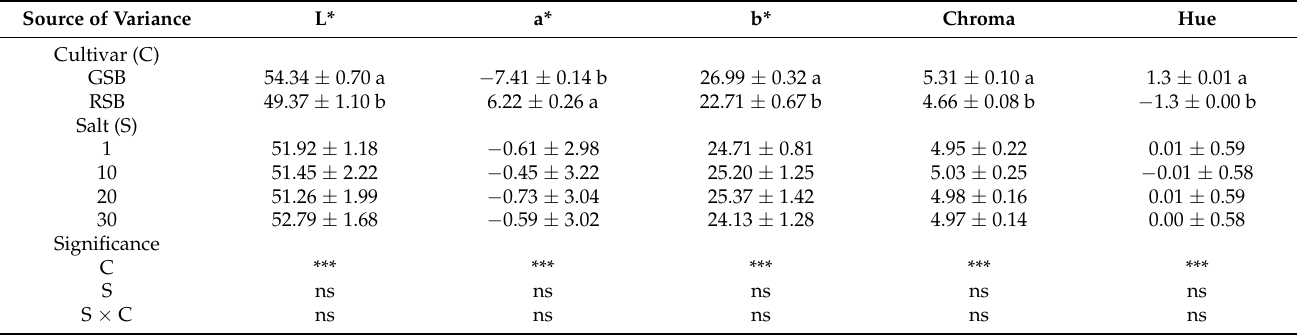
Table 2. Main effect of the cultivar (C), salt concentration (S; in mM NaCl), and their interaction on the colour parameters of the leaves. The significance of the factors and their interactions was evaluated with a two-way ANOVA (ns: not significant; *: p < 0.05; ***: p < 0.001), using Duncan’s multiple range test as post-hoc test for mean separation among conditions. In case of simple main effect of C or S, different letters indicate, for each variable, different homogenous groups according to Duncan’s test for S, or the Student’s t -test for C. GSB: ‘Green Salad Bowl’; RSB: ‘Red Salad Bowl’. Salt concentration is in mM NaCl. L* (lightness), a* (redness), b* (yellowness), and chroma (relative saturation) and hue indicate the color dimensions according to the CIELAB color space as defined by the International Commission on